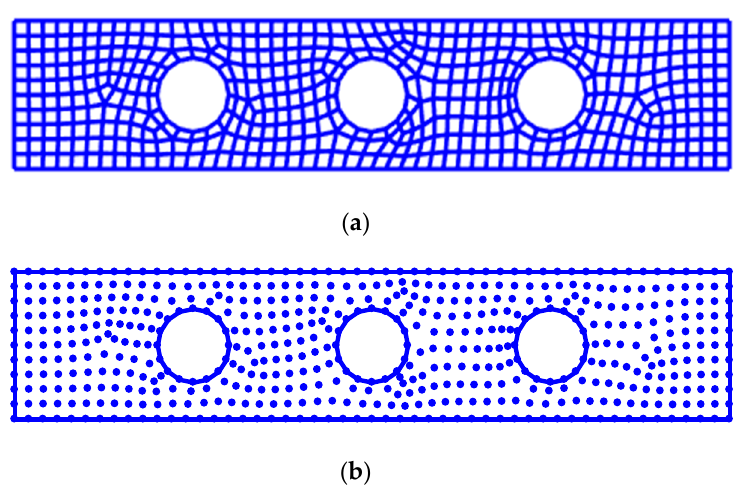
Figure 11. The node arrangement patterns employed to discretize the cantilever beam with three identical holes for the different numerical methods: ( a ) mesh pattern used to discretize the cantilever beam with three identical holes for the standard FEM-Q4; ( b ) node arrangement pattern used to discretize the cantilever beam with three identical holes for the RPIM and M-RPIM. Table 6. The first twelve natural frequency values computed using different numerical methods for the cantilever beam with three identical holes.